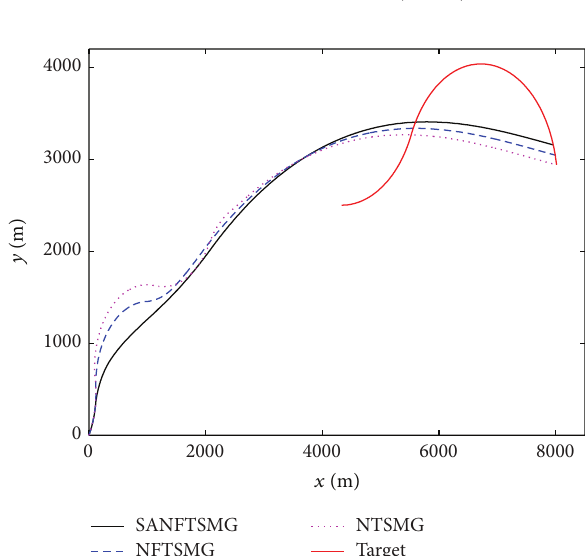
Figure 6: Missile acceleration (Case 1).